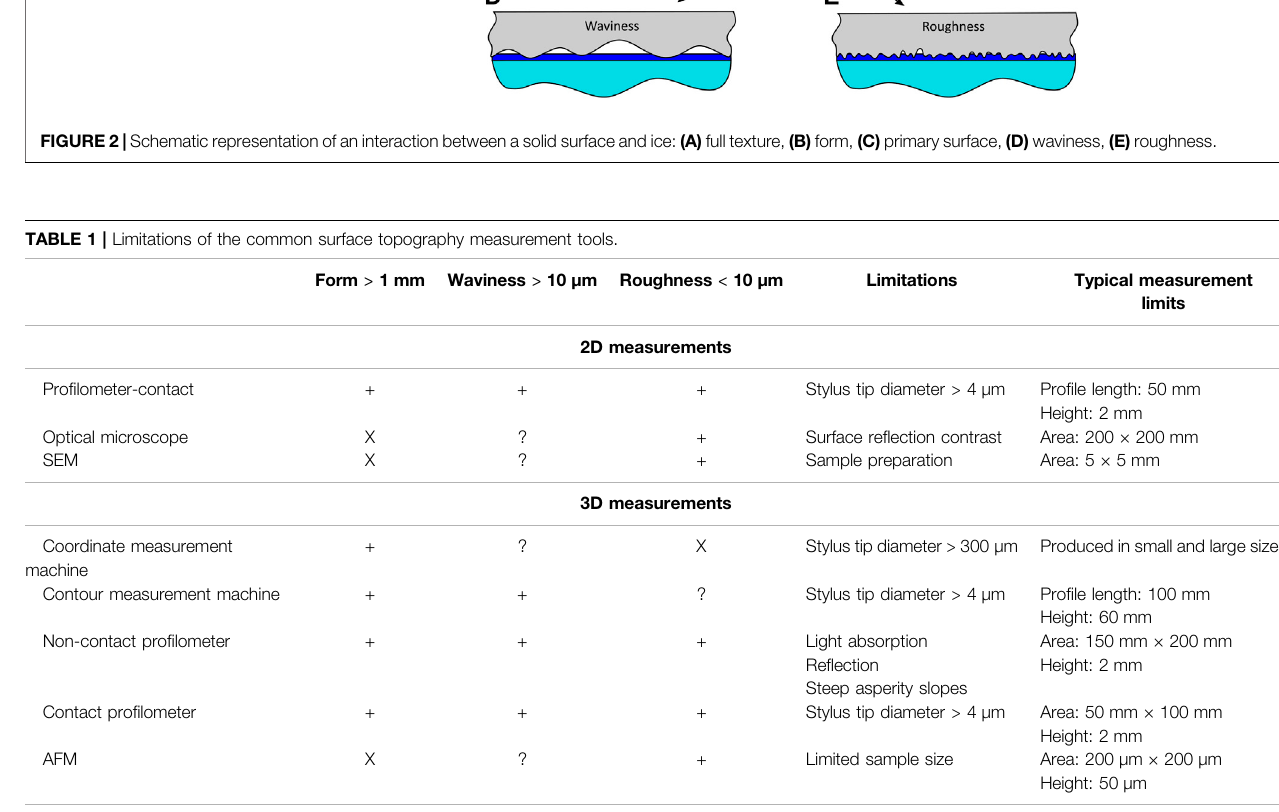
Symbols “ + ” , “ ? ” and “ X ” stand for “ measurement is possible ” , “ measurement is potentially possible ” , and “ measurement is not possible ” ,